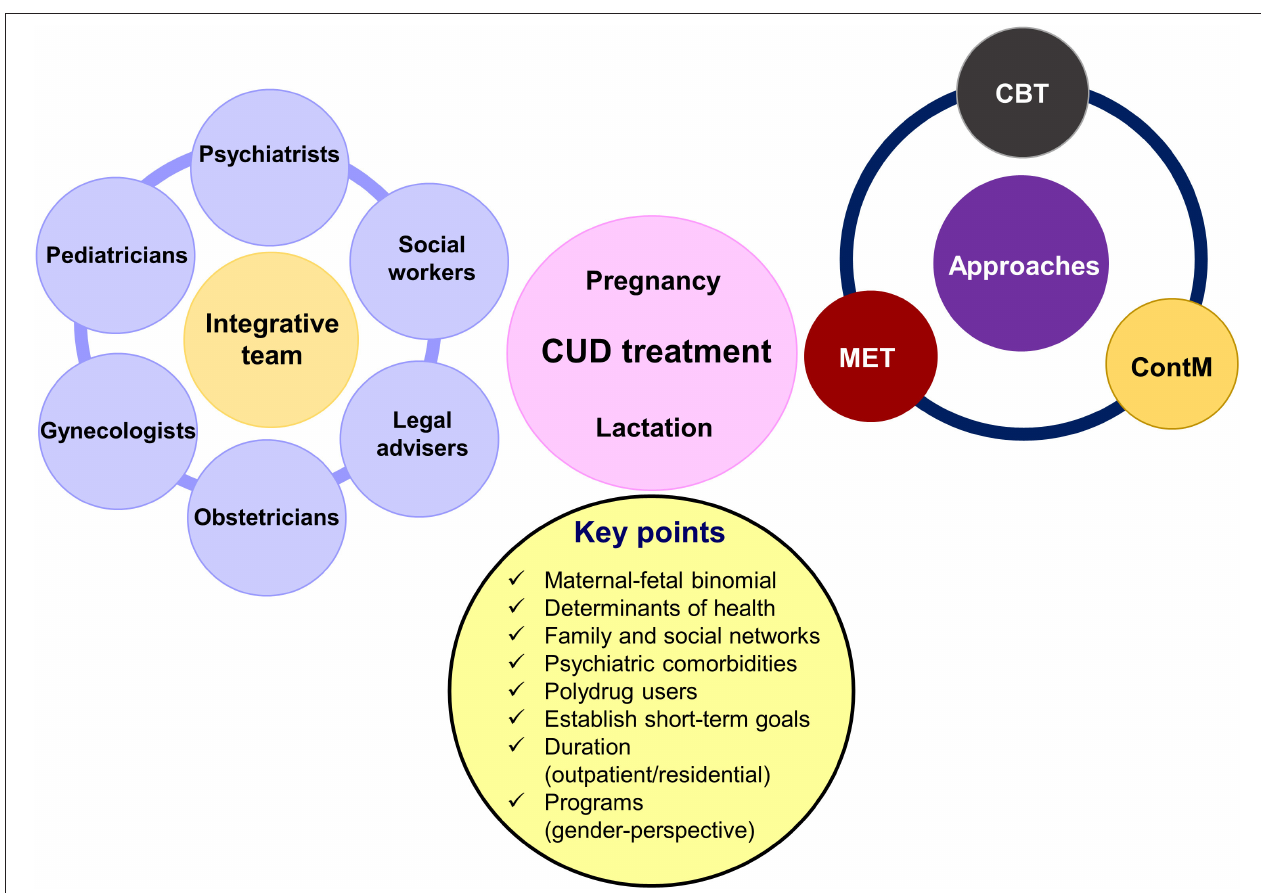
FIGURE 2 | Main characteristics of comprehensive treatment for women affecting by cannabis use disorder (CUD) during pregnancy and lactation. MET, motivation enhancement treatment; CBT, cognitive–behavioral coping skills training; ContM, contingency management